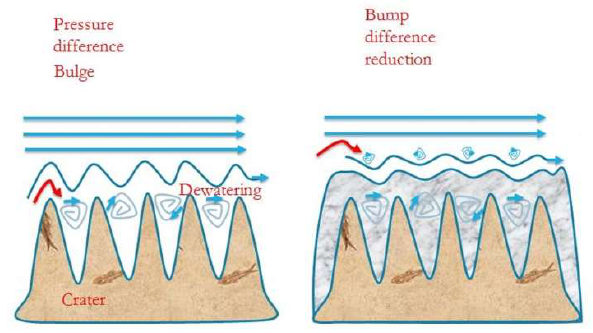
Figure 10. Resistance reduction mechanism.